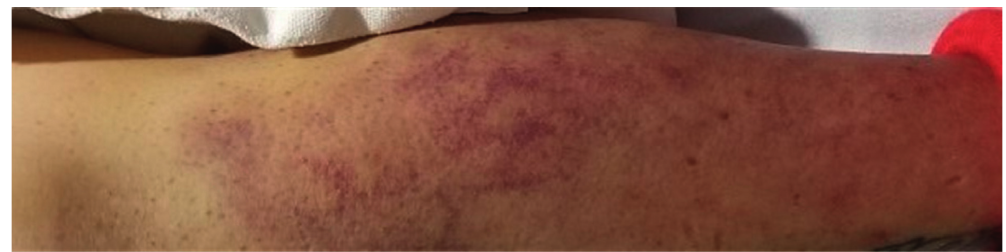
Figure 1: Peripheral ecchymosis which is commonly found as a cutaneous manifestation of scurvy.